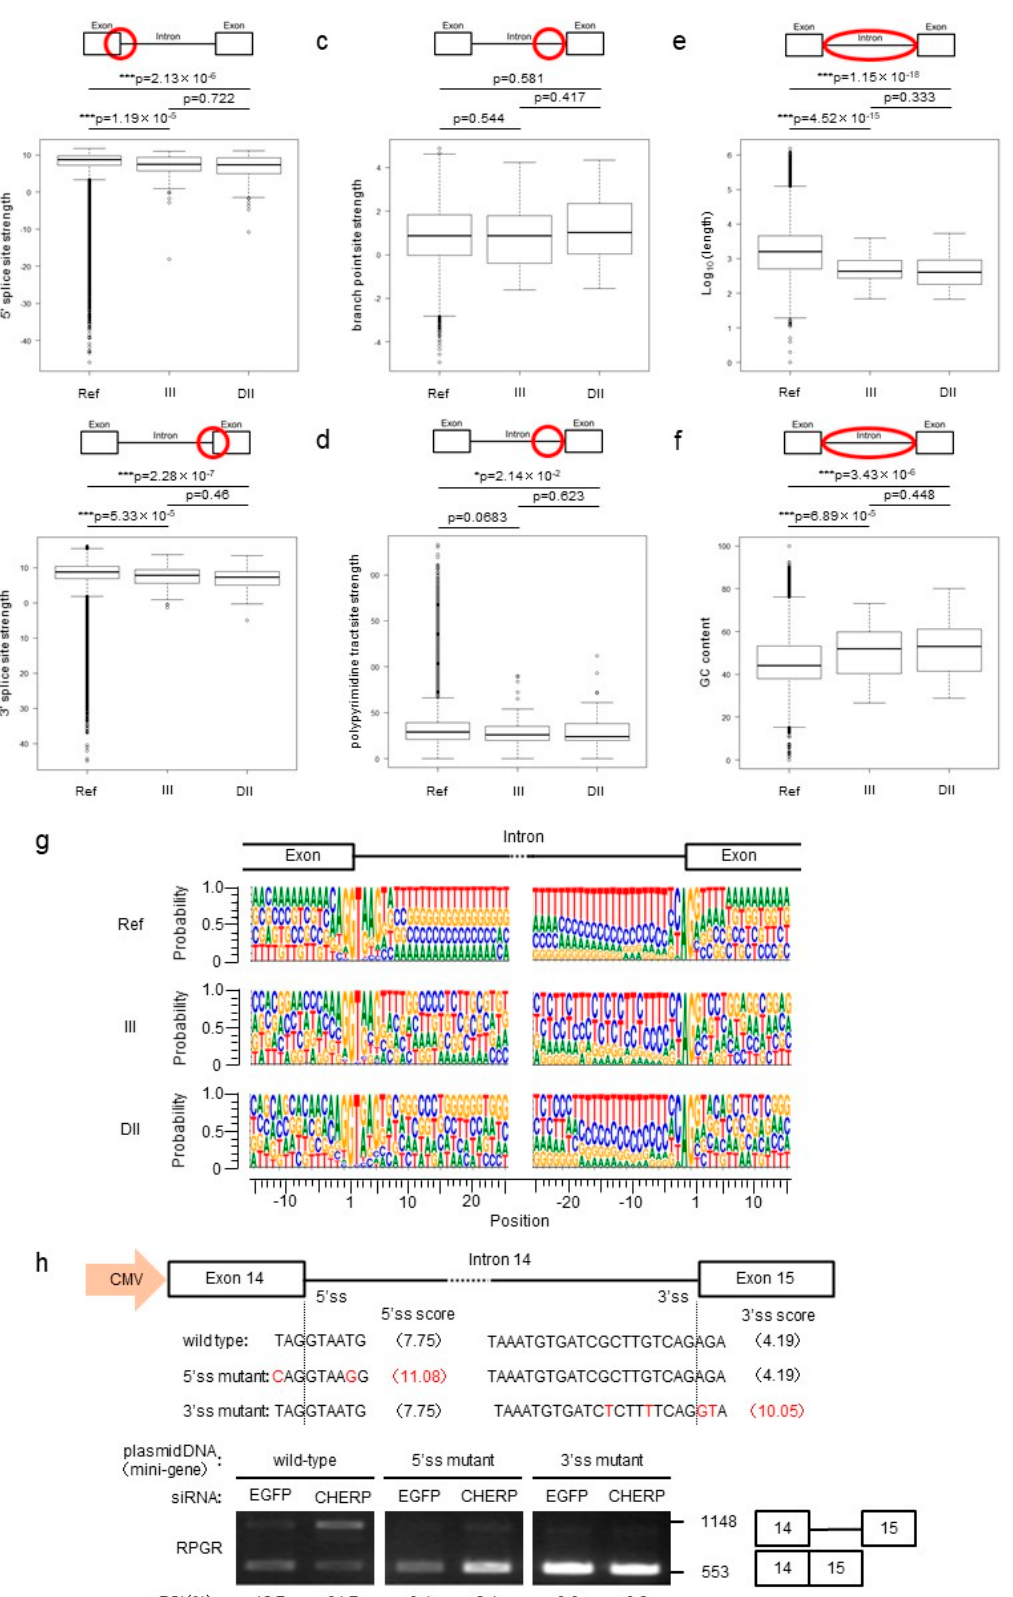
Figure 3. Characteristics of III and DII induced by CHERP depletion. ( a , b ) 5 ′ and 3 ′ splice site scores after CHERP depletion, calculated by MaxEntScan. ( c ) Branch point site scores after CHERP depletion, calculated by SVM-BPfinder. ( d ) Polypyrimidine tract site scores after CHERP depletion, calculated by SVM-BPfinder. ( e ,f) Length and GC content of CHERP-targeted introns, analyzed by